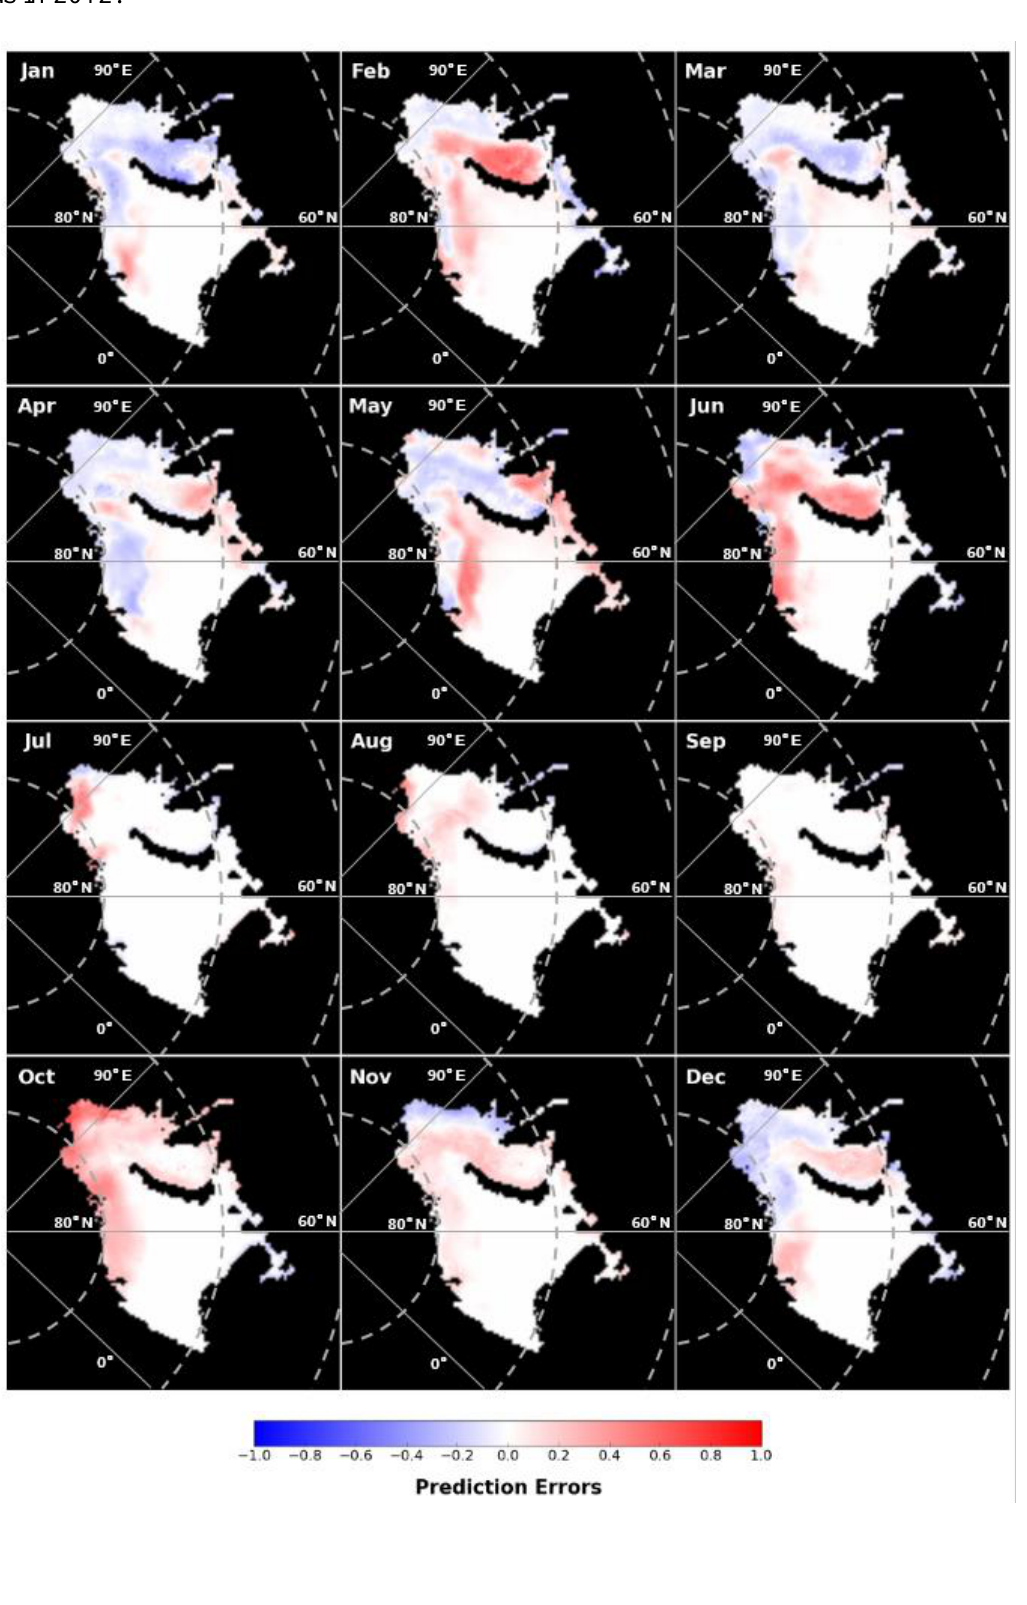
Figure 11. Prediction errors of the ARIMA regression models for the Barents and Kara Seas in